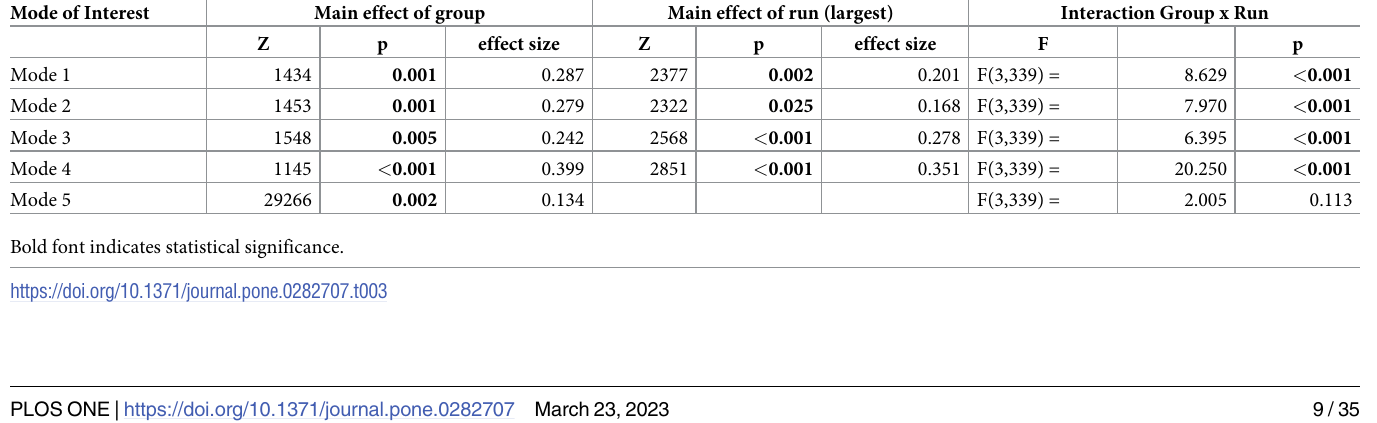
Table 3. Effects of group, run, and interactions between group and run, on local VAR in modes ψ 1 , ψ 2 , ψ 3 , ψ 4 , ψ 5 . Mode of Interest